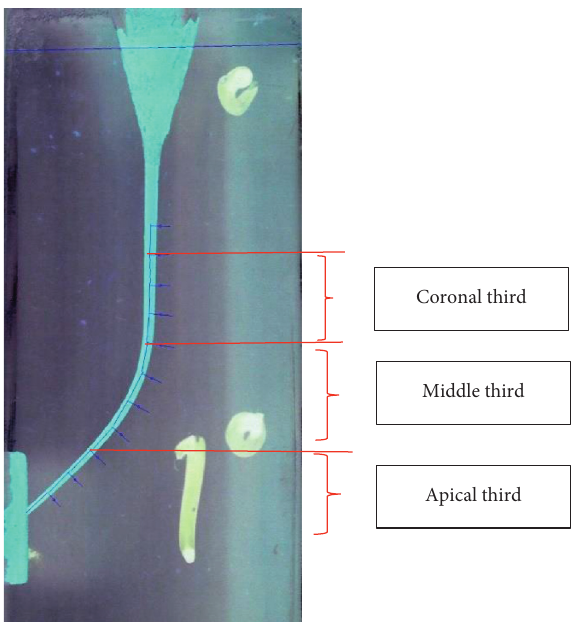
Figure 1: Pattern for transportation measurement of the frontal view of the block.